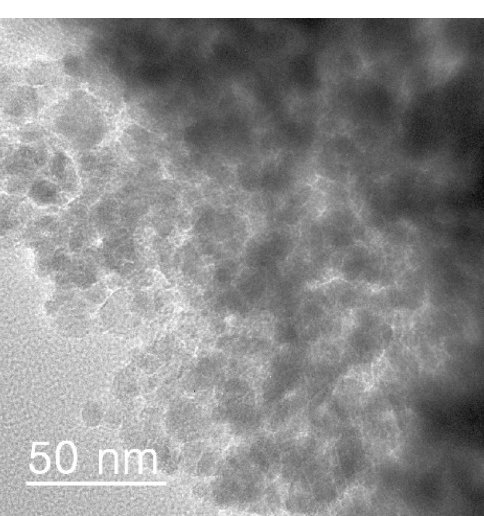
Figure 12. TEM image of the recycled Ps@Tet-Cu(II)@Fe 3 O 4